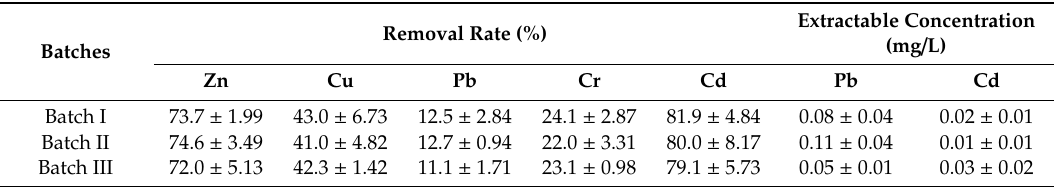
Figure 6. Variation of pH during bioleaching with the recovered sulfur prill-3. Table 3. Removal rate and extractable concentration of heavy metals after bioleaching with the recovered sulfur